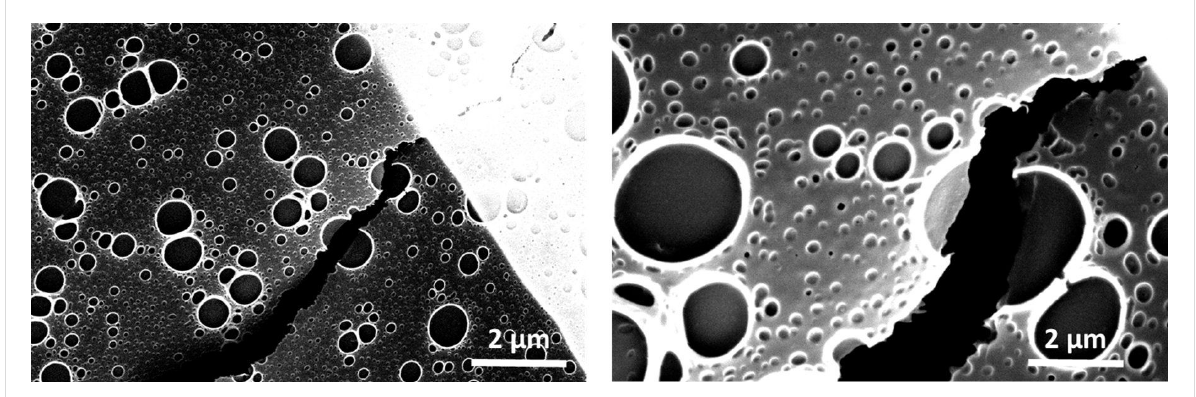
Figure 4: SEM images of freestanding CMP nanomembranes coated with a stabilizing PMMA layer containing large holes. The SEM images confirm the homogeneous thickness and freestanding nature of the CMP nanomembranes synthesized via TYC reaction.